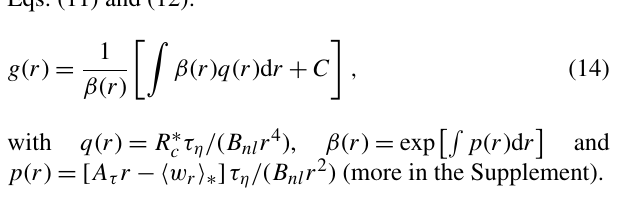
Figure 3. RDFs of particles ( St = 0 . 54) subject to action of turbu- lence and collision–coagulation with and without gravity. Circles: S g = 0 (zero gravity); triangles: S g = 4 . 9 (nonzero gravity). The latter shows a reduced slope in the power-law regime, while the shape of the two curves is largely similar in the collision regime ( r ∼ d ). Inset: MRVs of the same cases as in the main figure. Grav- ity weakens the MRV of the